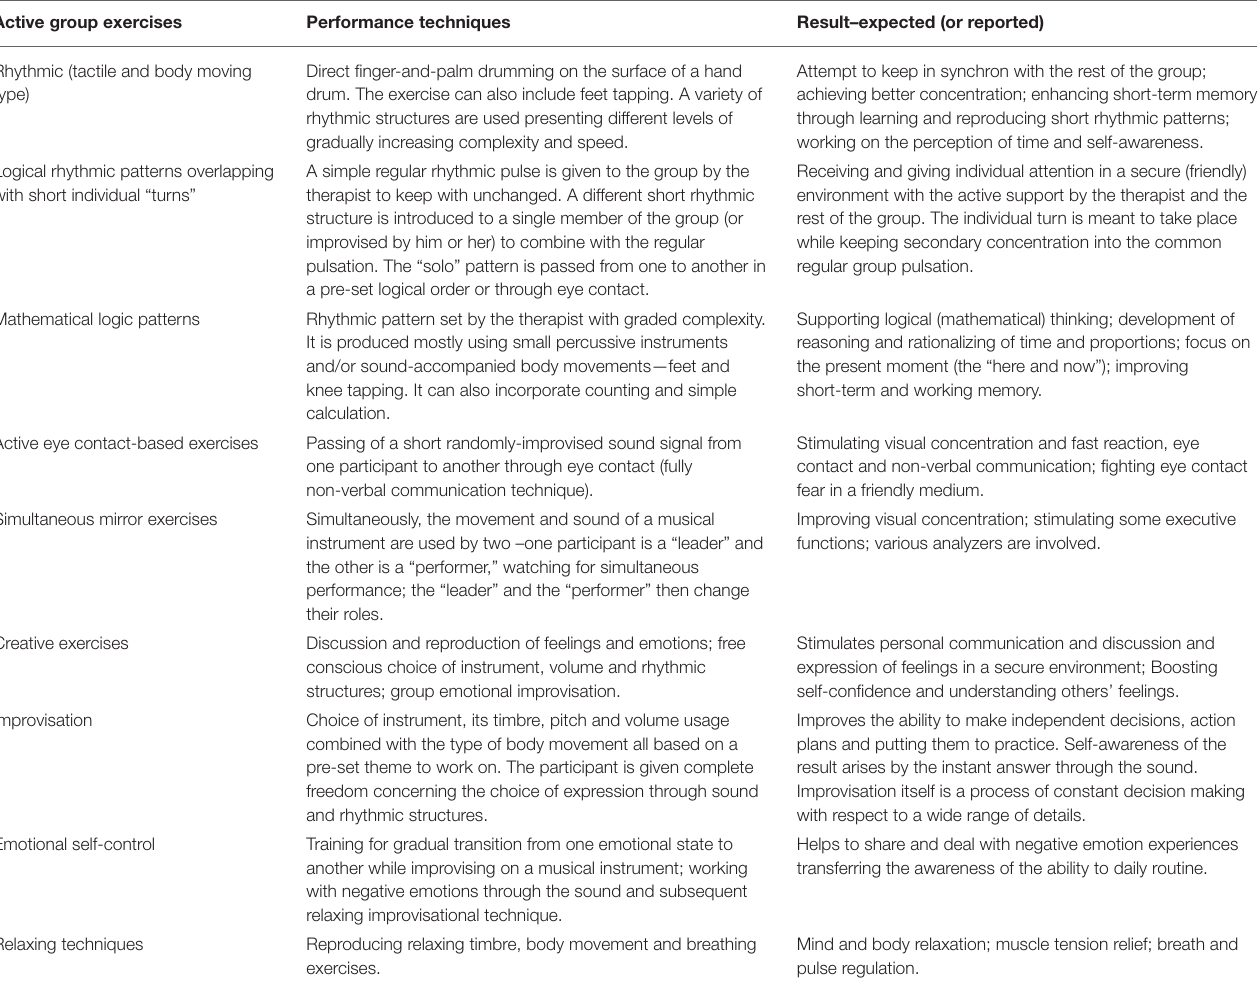
TABLE 1 | Summary of different forms of exercises that could be applied during musical